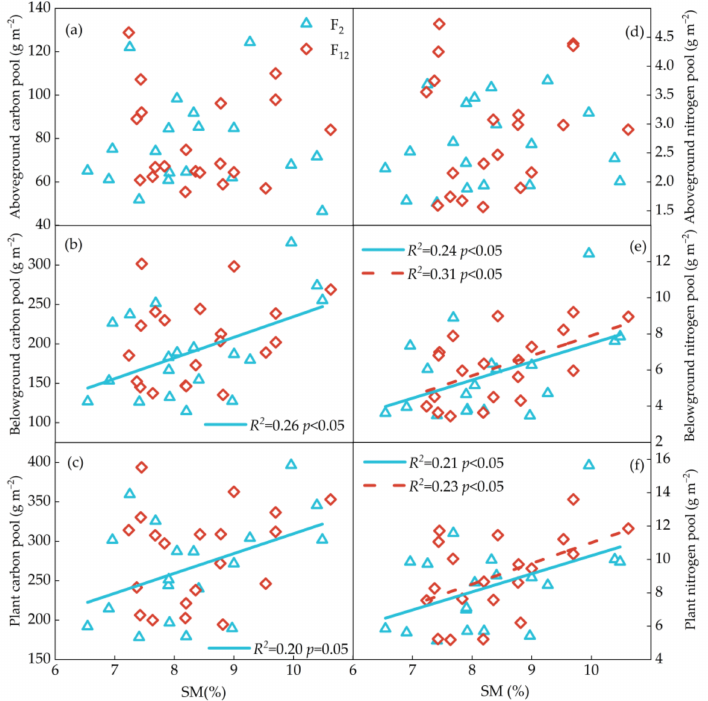
Figure 6. The relationships between soil moisture content (SM) and PAGC ( a ), PBGC ( b ), PC ( c ), PAGN ( d ), PNGN ( e ) and PN ( f ). Blue triangles with solid lines indicate 2 N additions yr − 1 (F 2 ). The red quadrilateral and dotted line indicate once a month (F 12